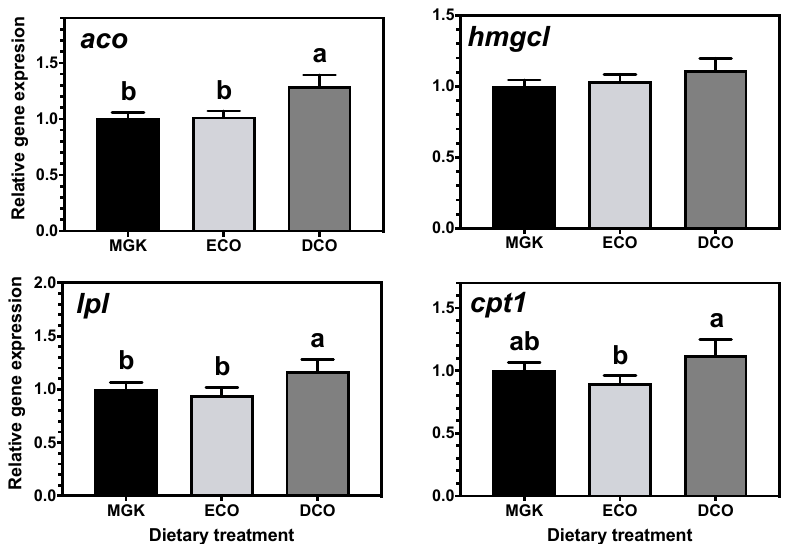
Figure 3. Nutritional regulation acyl coA oxidase ( aco ), lipoprotein lipase ( lpl ), 3-hydroxy-3- methylglutaryl-CoA lyase ( hmgcl ) and carnitine palmitoyl transferase I ( cpt1 ) gene transcription in liver of Atlantic bluefin tuna ( Thunnus thynnus L.) juveniles fed a reference diet Magokoro ® (MGK) and two test diets containing either EPA (ECO) or EPA + DHA (DCO) oils from transgenic Camelina sativa seeds. Values are normalised expression ratios to MGK reference diet and are means ± SD ( n = 6). Values with different superscript letters are significantly different (one-way ANOVA and Tukey test; p < 0.05). Similar to the liver, the expression of the aco and lpl genes in the intestine presented the same pattern but, in contrast to the liver, both genes were significantly upregulated in the intestine of fish fed diet DCO compared to fish fed the MGK and ECO diets (Figure 4). While the expression of hmgcl in the fish intestine was not significantly affected by diet, the expression of cpt1 in the intestine was higher in the fish fed diet DCO compared to fish fed the ECO diet, with fish fed MGK being intermediate and not different to either.